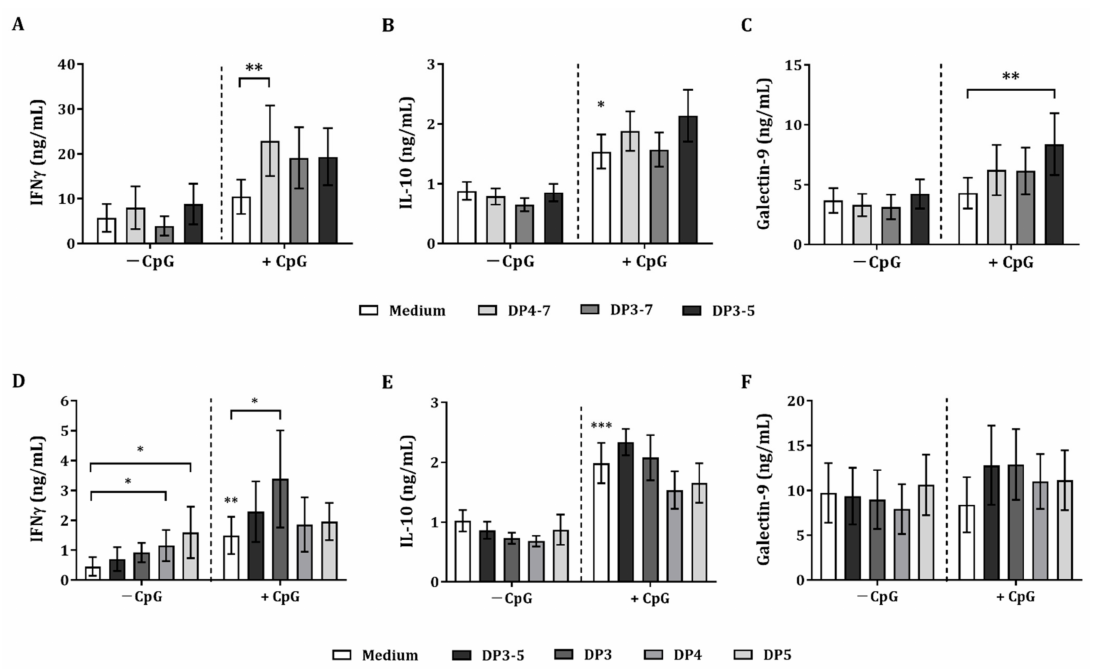
Figure 3. Cytokine and galectin-9 secretion in IEC/PBMC co-culture. IECs were apically exposed to GOS DP4-7, DP3-7, and DP3-5 in combination with 5 µ M CpG and basolaterally to α CD3/CD28- activated PBMC. Additionally, GOS DP3-5 was further separated into DP3, DP4, and DP5 fractions. IEC were apically exposed to GOS DP3, DP4, and DP5 in combination with 5 µ M CpG and basolater- ally to α CD3/CD28-activated PBMC. After 24 h of incubation, IFN γ ( A , D ), IL-10 ( B , E ), and galectin-9 ( C , F ) concentrations were measured in the basolateral supernatant. Data represent mean ± SEM of n = 6 independent PBMC donors (except for n = 4 in ( A ) and n = 5 in ( C , D )). Statistical analysis was performed separately for conditions with and without CpG (represented as dotted line). However, a comparison between the medium control and CpG-exposed condition was included (* p < 0.05, ** p < 0.01, *** p <